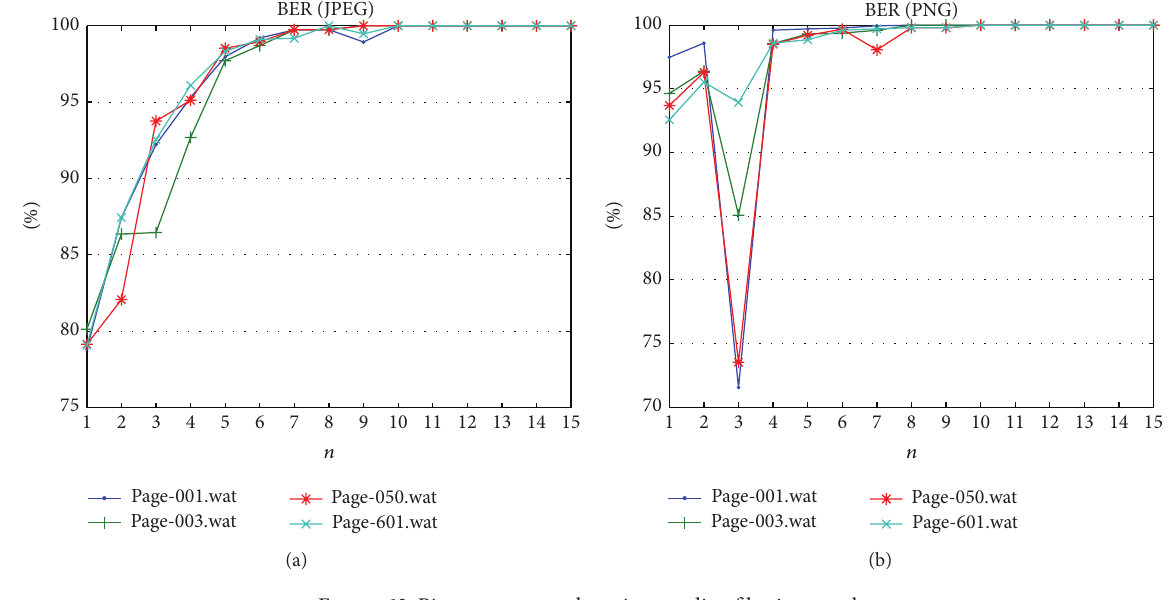
Figure 13: Bit error rate result against median filtering attack.